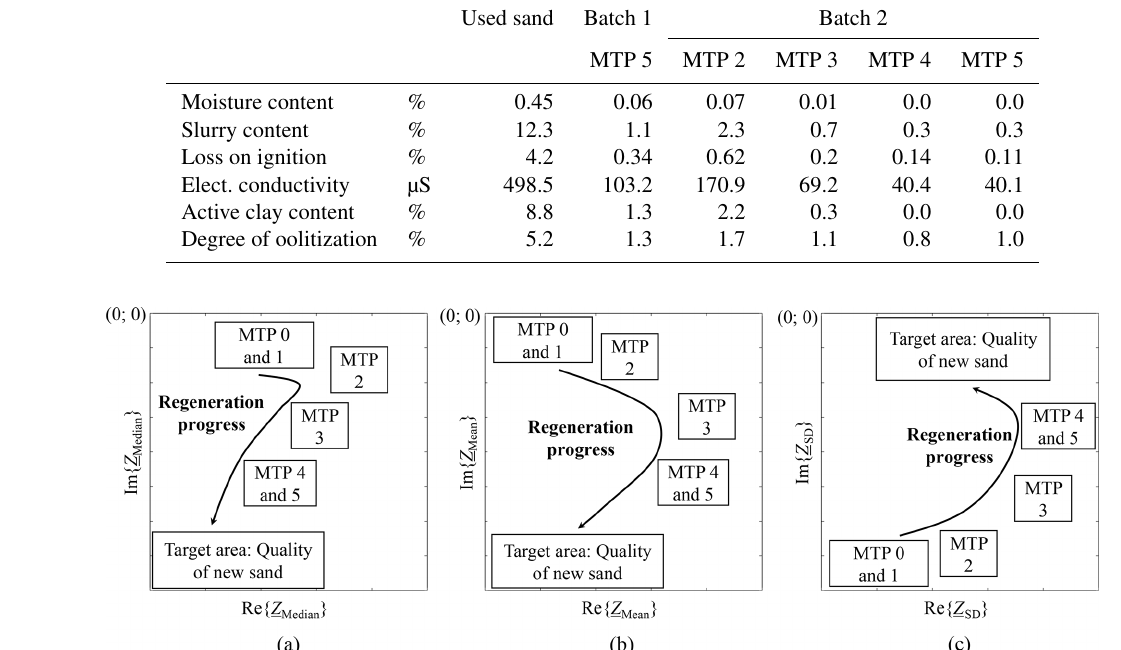
Figure 13. Impedance features as functions of the regeneration progress in batch 2. (a) “Median” feature. (b) “Mean” feature. (c) “Standard deviation”